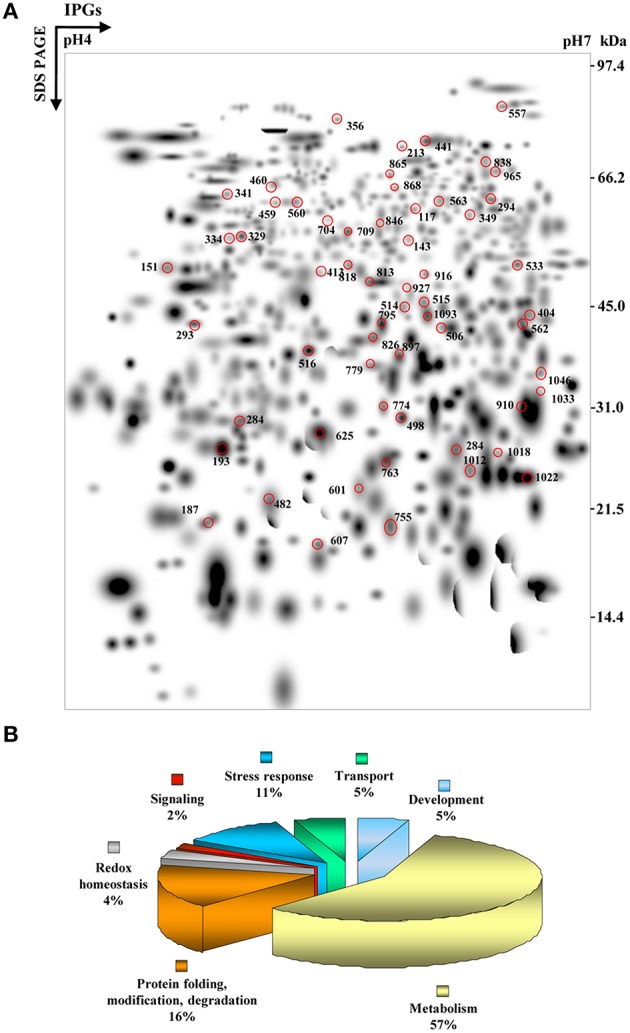
Higher level match set and functional cataloging of PSRPs. (A) The match set was created in silico from three standard gels for each of the time points as depicted in Supplementary Figure S1. The numbers indicate spots listed in Supplementary Table S2 identified by MS/MS analysis. (B) Pie chart showing the functionally categorized PSRPs.